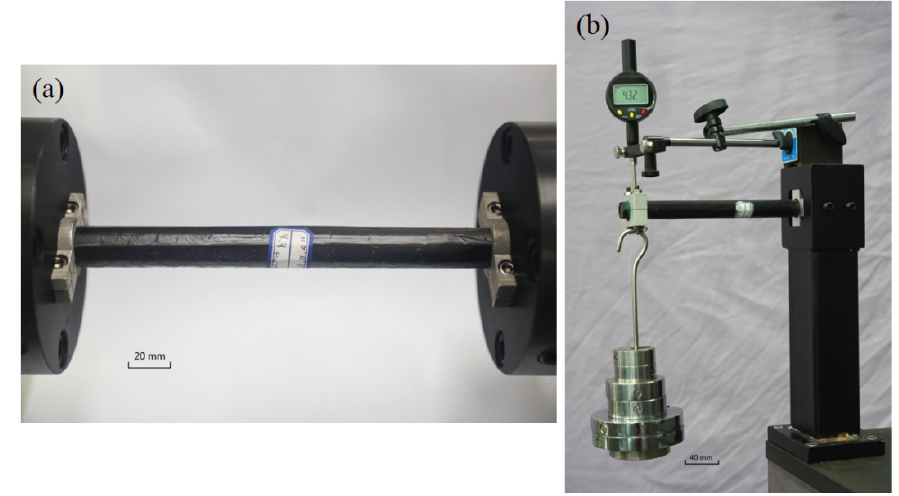
Figure 1. Test device. ( a ) Torsion test. ( b ) The cantilever beam